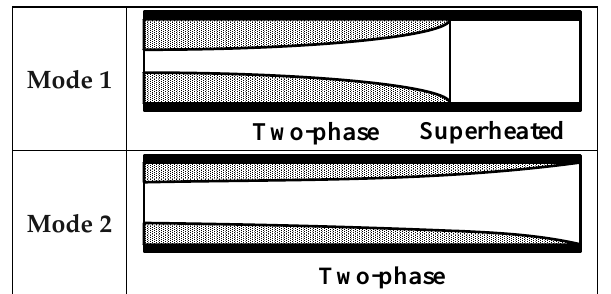
Figure 2. Modes of the evaporator.